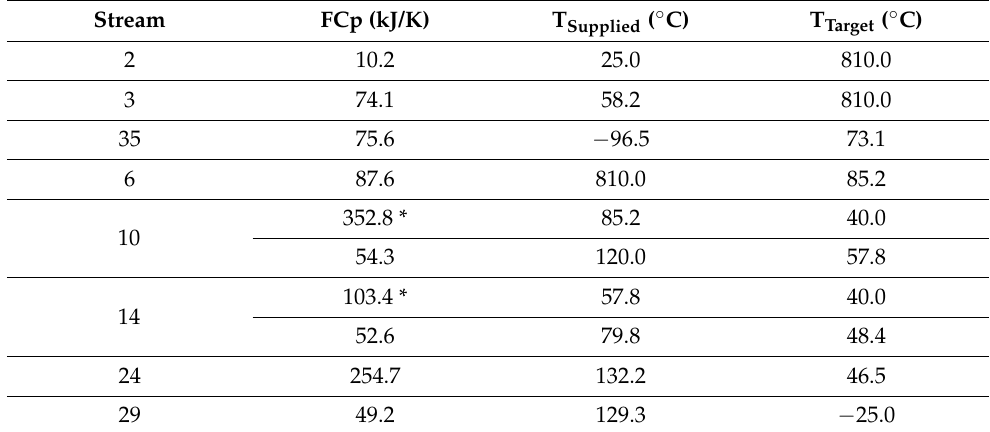
Table 4. Stream identification of the OCM